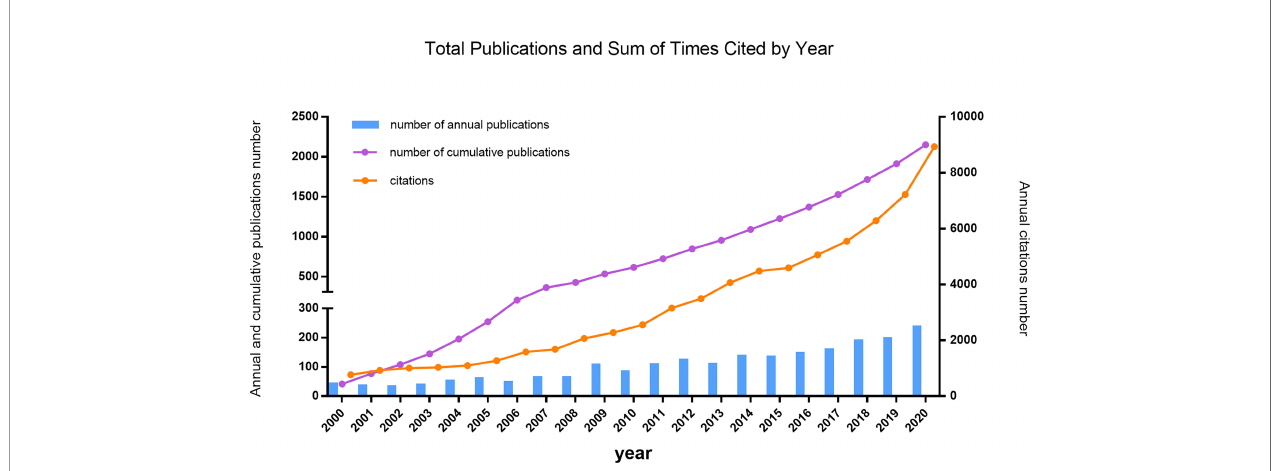
FIGURE 1 | The number of annual and cumulative published articles, and the sum of annual citations related to pathogen detection for CNS infection research, from 2000 to 2020.